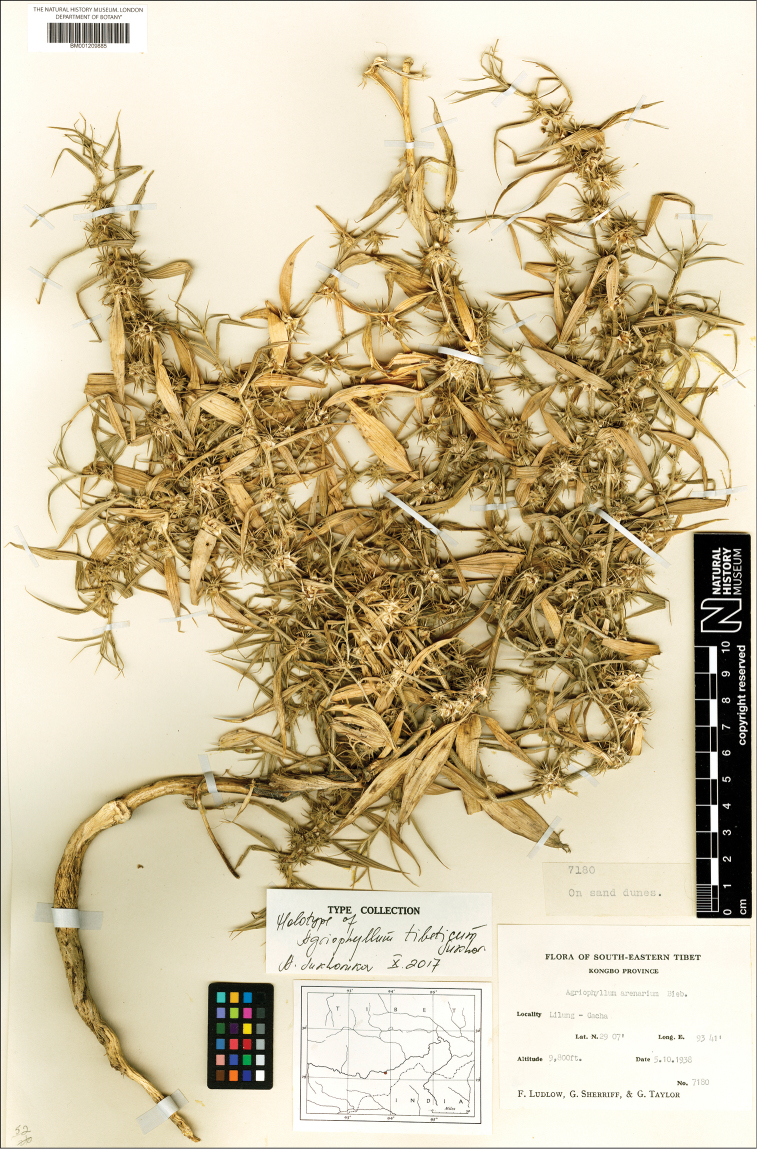
Holotype of Agriophyllumtibeticum Sukhor. sp. nov. (BM001209885).